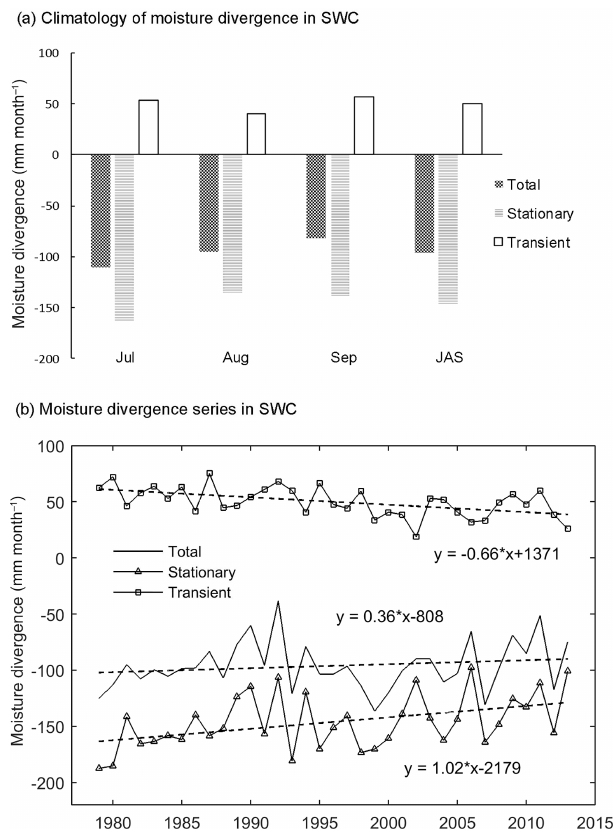
Figure 5. (a) Areal moisture divergence and its stationary and transient components over the SWC (unit: mmmonth − 1 ) for July, August, and September during 1979–2013. (b) Moisture diver- gence in JAS and its stationary and transient components (unit: mmmonth − 1 ) over the SWC during